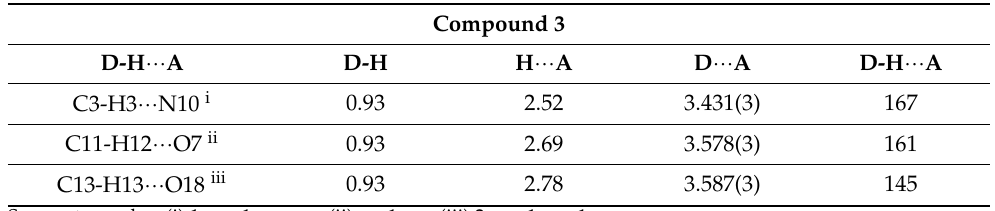
Table 5. Selected hydrogen-bond geometry (Å, ◦ ) for 3